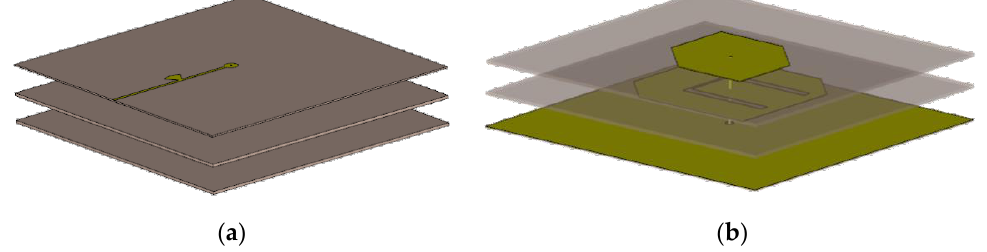
Figure 1. Microstrip Patch antenna geometry. ( a ) Top view; ( b ) Bottom view.